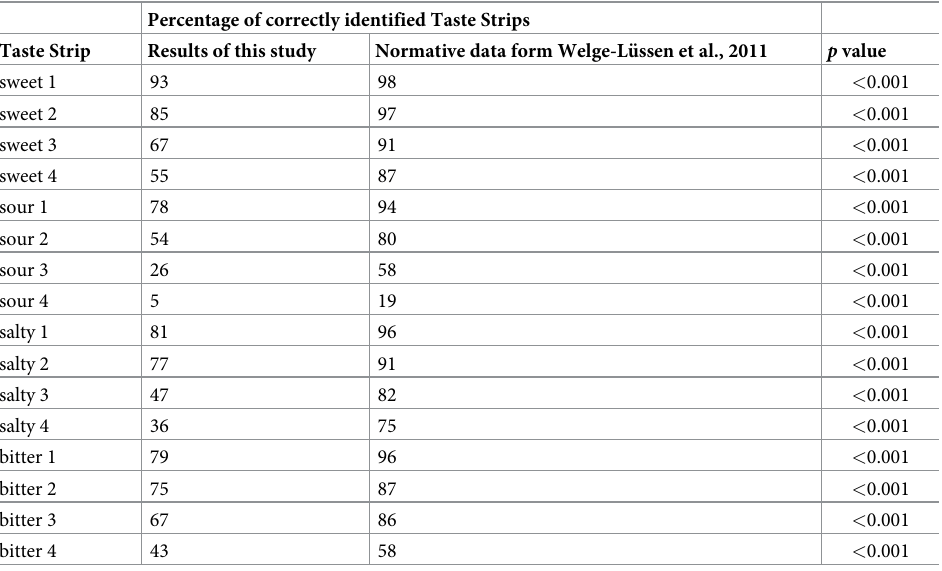
Correctly identified Taste Strips in this study compared to normative data by Welge-Lu¨ssen et al. [16] (Z-test; note that the higher the number of the Taste Strip the lower its concentration; exact concentrations are provided in the methods